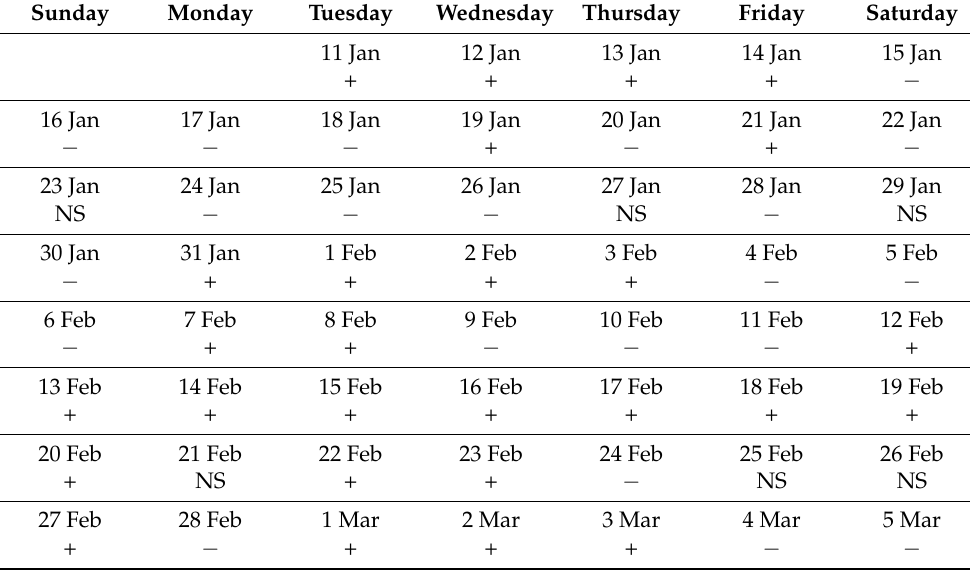
Table 2. Detection of SARS-CoV-2 in the Sludge Fraction of Wastewater in